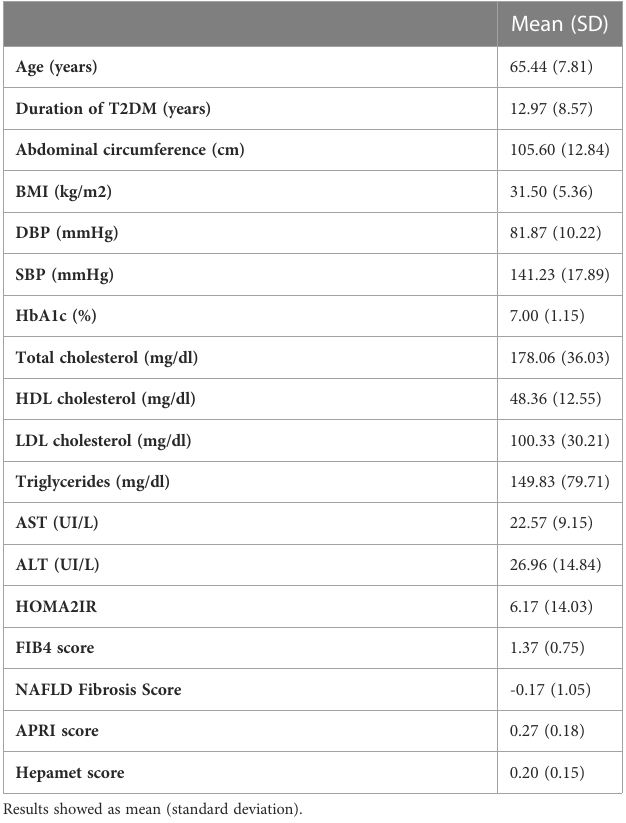
TABLE 1 Demographic and clinical